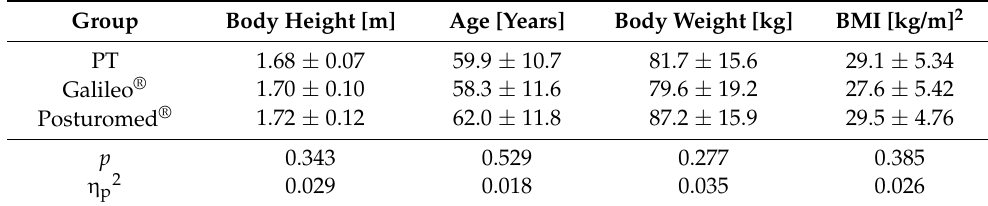
Table 1. Demographic and anthropometric data of the sample (n = 75). Values are given as mean ± standard